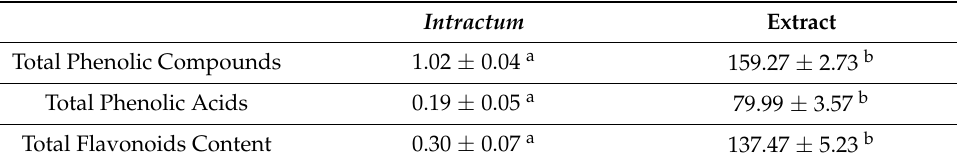
Table 1. Chemical composition of the E. senticosus intractum and the extract [mg/g ext. ± SD]. Different superscript letters within the same row indicate statistically significant differences with p <